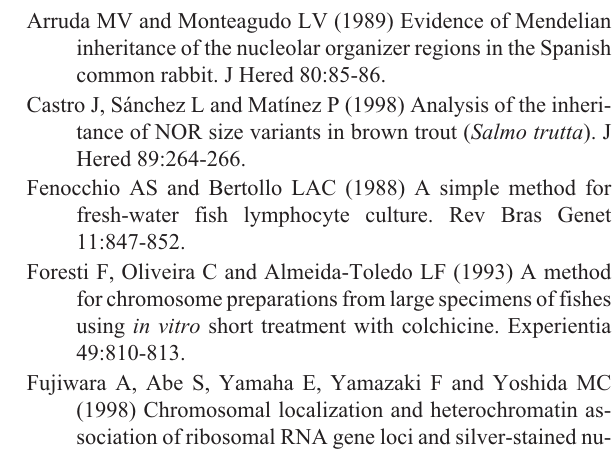
Table 1 - Survival of larvae and eyed embryos in artificial crosses involving breeders of rainbow trout ( Oncorhynchus mykiss ) with different phenotypes for the NOR-bearing chromosomes. Crosses Initial number of Number of eggs lost up to Eyed embryos Number of eggs lost up oocytes the eyed-embryo stage N / % to the larval